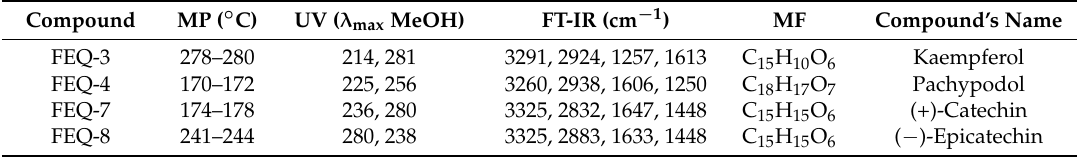
Table 5. Identification of the aglycone flavonoids isolated from the methanol extract of E. spiralis stem bark.